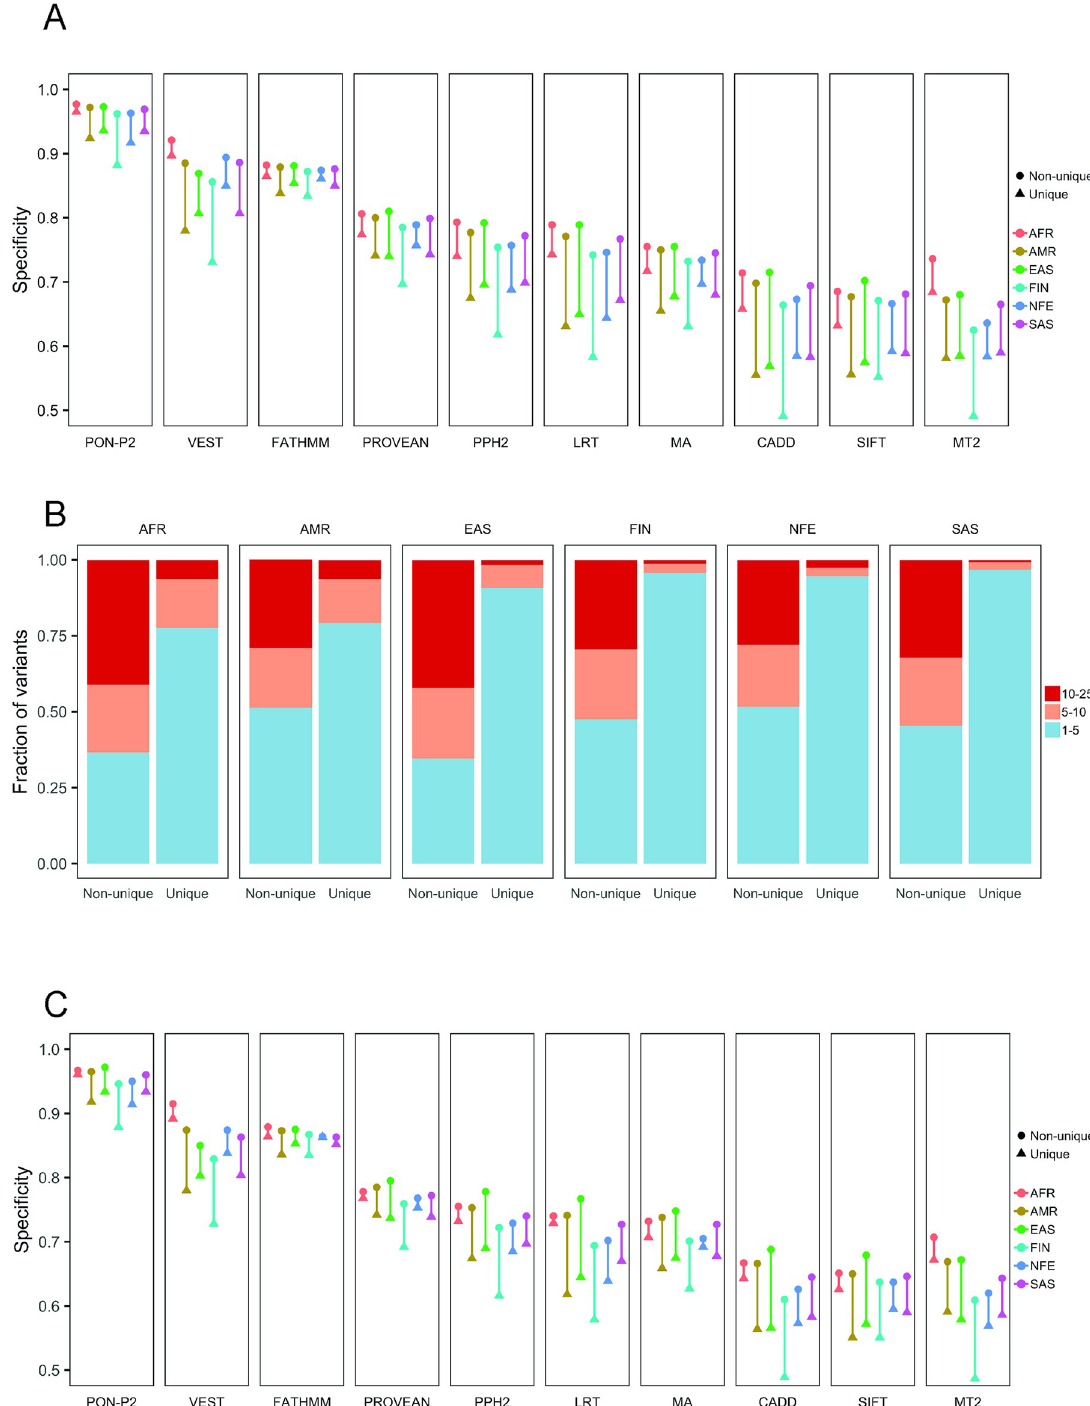
Fig 3. Analysis of unique and non-unique variants in populations. (A) Performance of tools on unique and non-unique variants with different minor allele frequencies in different populations. AFR, African; AMR, American; EAS, East Asian; FIN, Finnish; NFE, Non- Finnish European; SAS, South Asian. The unique dataset contains variants with AF � 1% and < 25% in the specific population but < 1% in all other populations and the non-unique dataset consists of the remaining variants. The differences are shown by the lines containing the values for each population. (B) Fractions of unique and non-unique variants in relation to AF. The colors for AF ranges are shown to the right. (C) Specificities of prediction tools on unique and non-unique variants (AF 1–5%) for each ancestry group. Unique